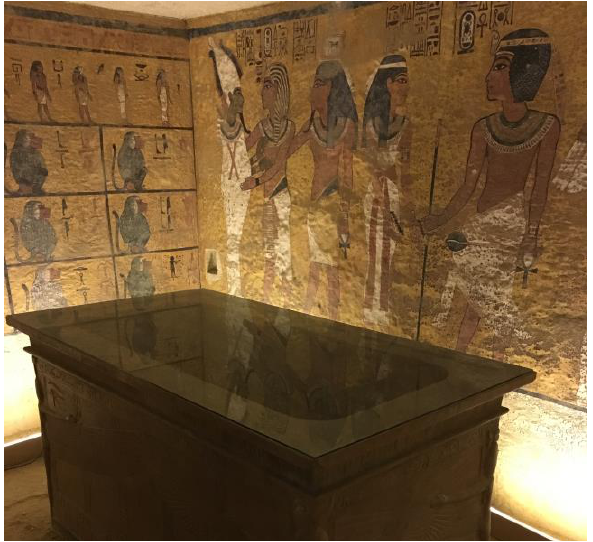
Figure 4. The replica tomb of Tutankhamen at Carter House © J. Paul Getty Trust